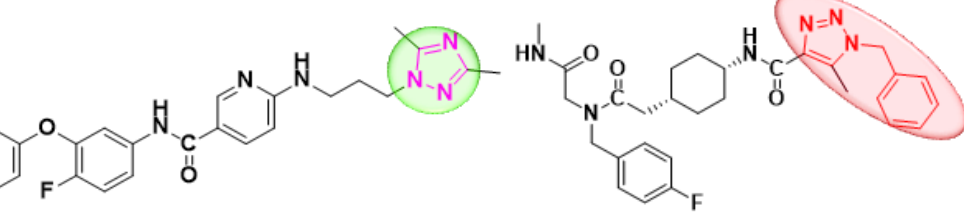
Figure 2. Representative structure of 1,2,3 and/or 1,2,4-triazole derivatives that exhibit InhA inhib- itors previously described in the literature.